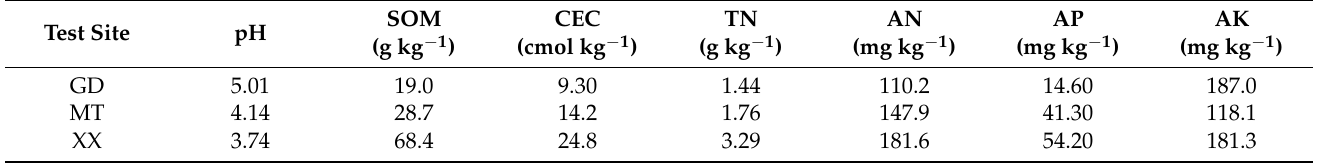
Table 1. Soil properties that existed at each site before the